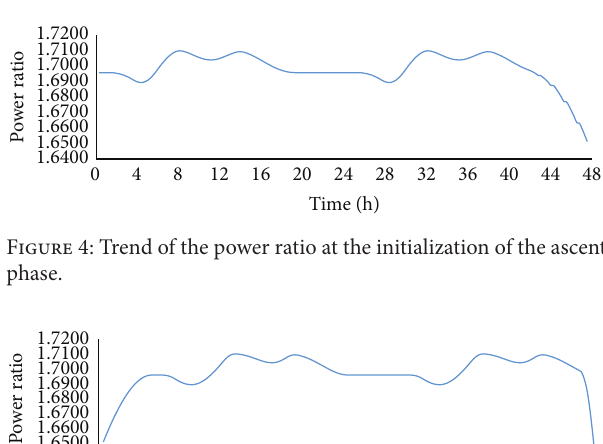
Figure 7: Trend of the power ratio with respect to the start times of the cruise and ascent phases.